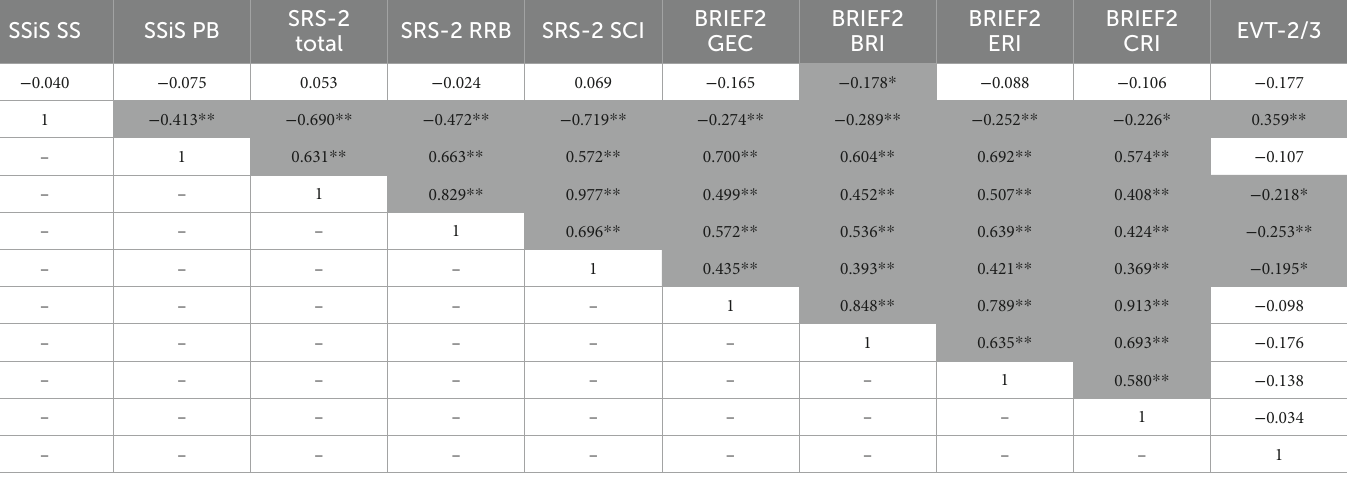
TABLE 3 Pearson’s r correlation coefficients for SSiS composite scores and other study measures.